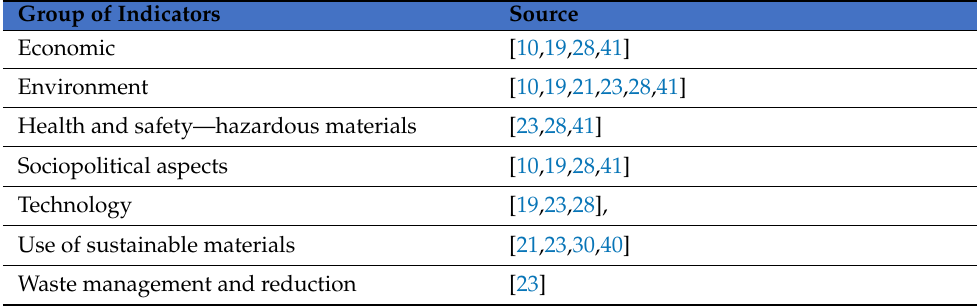
Table 2. Semantic integration of indicators groups (own elaboration).